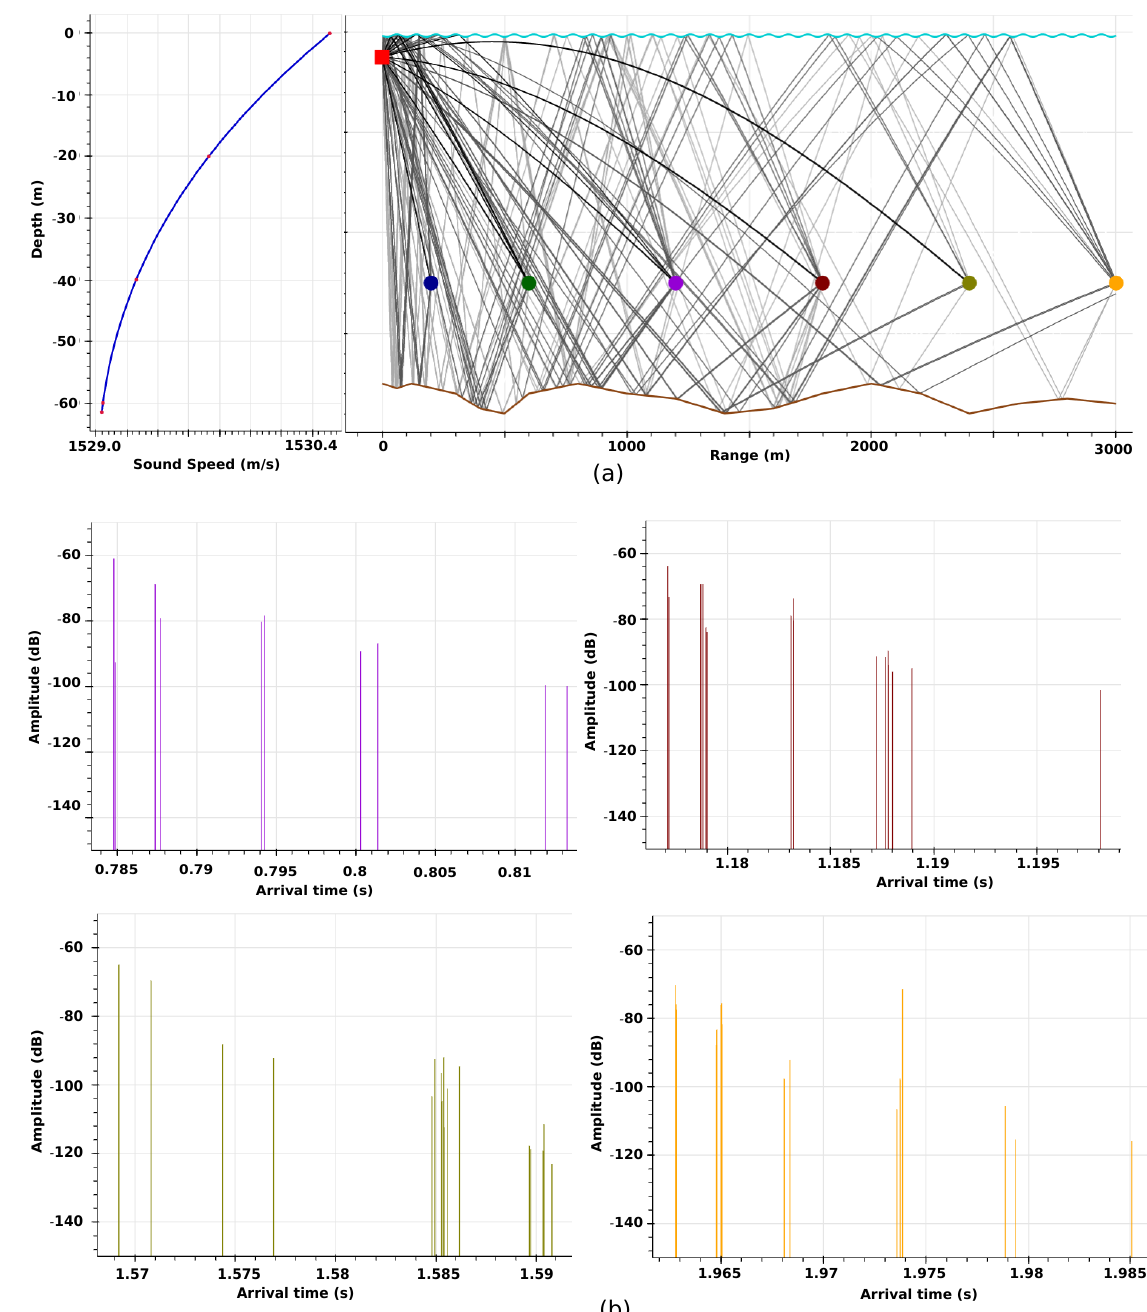
Figure A1. Multipath propagation of acoustic in shallow water. The plots are generated by BELLHOP ray tracing model [18,19]. ( a ) Left panel shows depth vs. sound speed, and right panel shows multipath propagations: the thick lines at the top (light blue) and the bottom (brown) represent the sea surface and seabed profiles, respectively. The red square represents a transmitter, and 6 discs in different colors at 40 m depth represent receivers at different horizontal ranges: 200,600,1200,1800,2400,3000 m from the transmitter. The light and dark gray lines between the transmitter and receivers represent eigen rays . Eigen rays are those rays that arrive at the receivers among all other rays emitted by the transmitter. ( b ) Amplitude vs. arrival times of eigen rays: vertical bars in respective colors represent clusters of eigen rays arriving at the respective